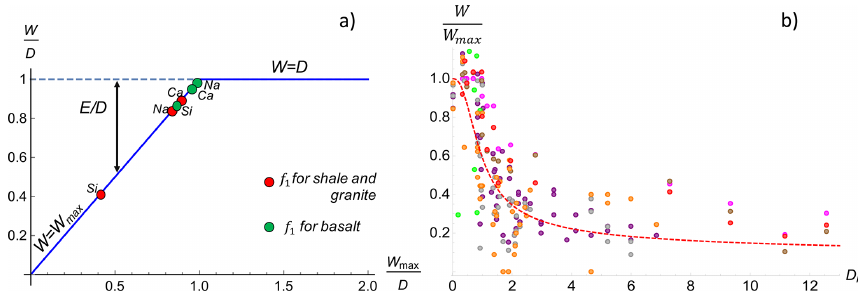
Figure 4. (a) Analysis of the self-similarity hypothesis in Eq. (24); (b) specific weathering rates as a function of the dryness index; dashed line shows Eq. (26). After Calabrese and Porporato